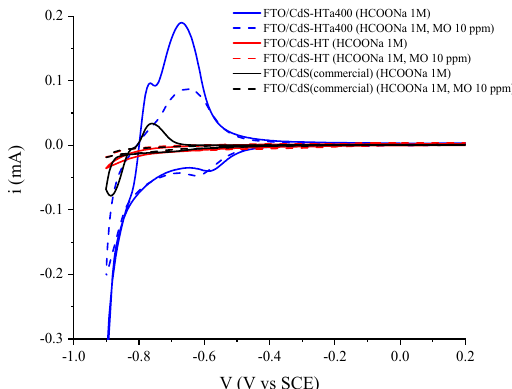
Figure 10. Dark cyclic voltammetry (0.2 V/ − 1 V vs. SCE) of FTO/CdS-HTa400 (blue), FTO/CdS-HT (red) and FTO/CdS (commercial, black) electrodes in an aqueous solution containing HCOONa (1 M) in the absence (solid lines) and in the presence of MO (10 ppm) (dashed lines).